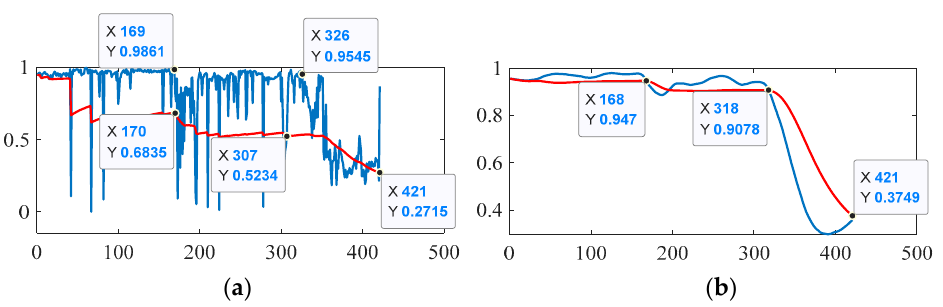
Figure 12. SDE and SDE feature curve (blue curve) and corresponding state warning line (red curve). ( a ) SDE; ( b ) smooth SDE.